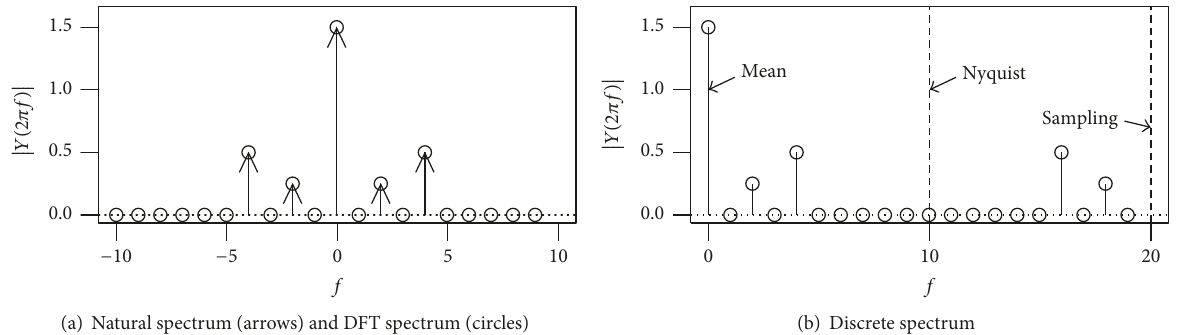
Figure 6: Two spectra of function (25). The difference between the natural spectrum in (a) and the normal discrete Fourier transform in (b) is the symmetry. In (a), there is a symmetric spectrum around zero, whereas in (b) the point of symmetry is 𝑓 s /2 . The dots in panel (a) indicate the result of the DFT of the modulated sampling series of (25). Note the exceptional first bin in (b), where the mean value is